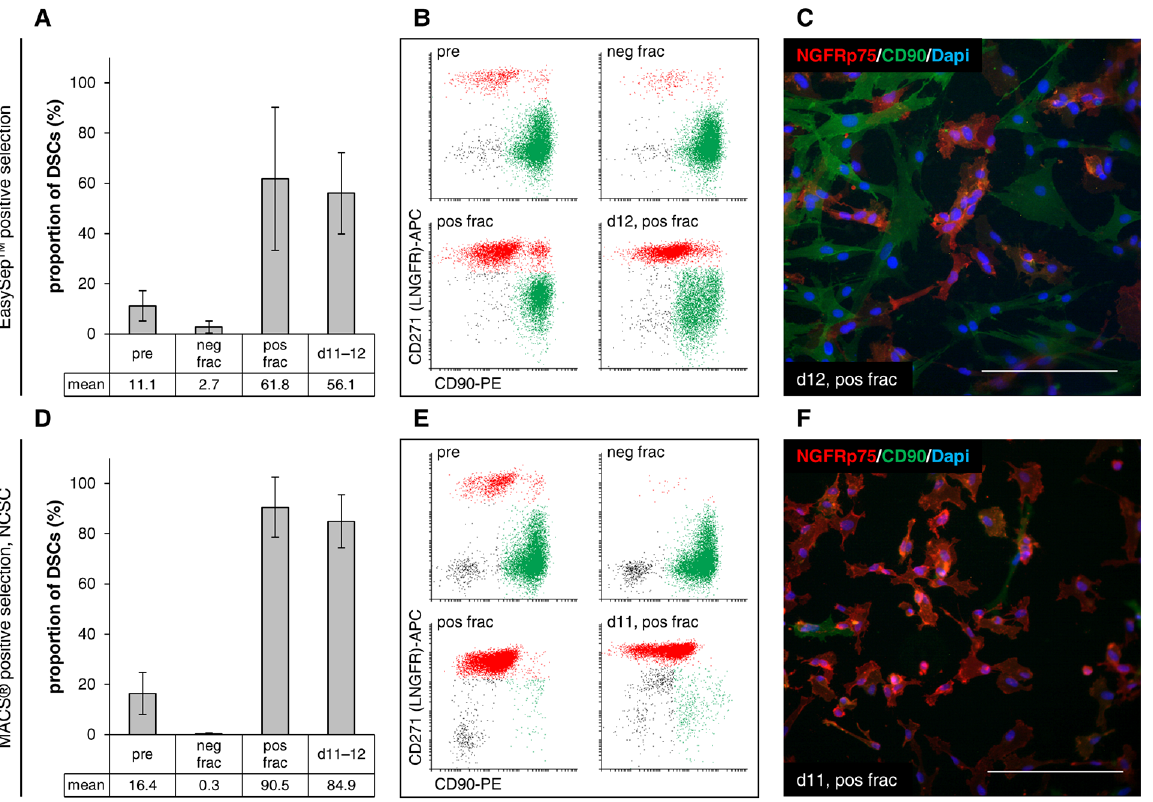
Figure 5. Positive selection (labeling of DSCs). ( A – C ) EasySep™ column ‐ free positive selection with the EasySep™ Human CD271 Positive Selection Kit II (StemCell Technologies). Sample size: n = 6. ( D – F ) MACS ® automatic column ‐ based positive selection with Neural Crest Stem Cell (NCSC) Mi ‐ croBeads and the autoMACS ® Pro Separator (Miltenyi Biotec). Program: Posseld2 . Sample size: n =